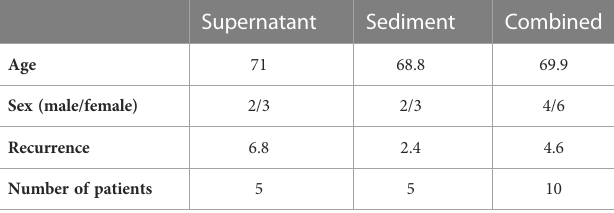
TABLE 1 Study population.